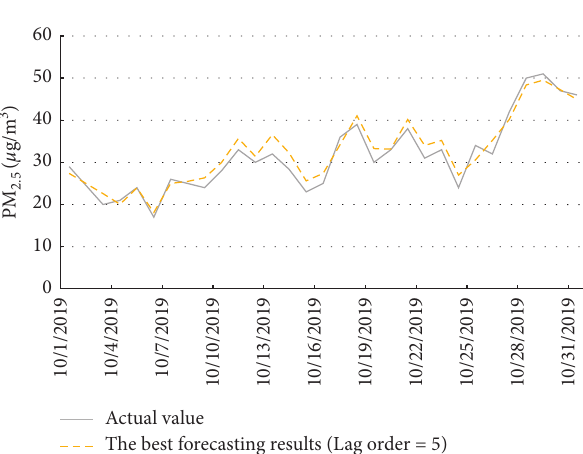
2.5 concentrations at